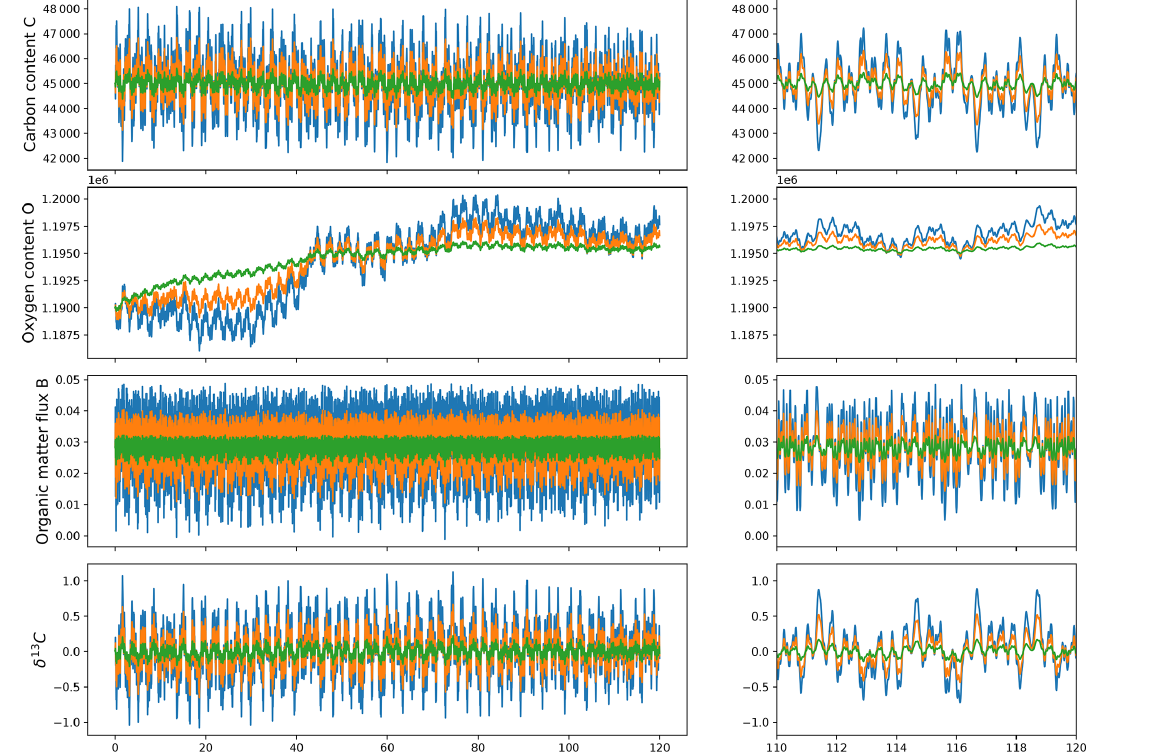
Figure 6. Modelled carbon content, C; oxygen content, O; organic matter flux, B ; and δ 13 C for different a f values ( a f = 0 . 01 in green, a f = 0 . 03 in orange, and a f = 0 . 05 in blue) when B 0 is a constant. The right panel is a zoom on the last 10Myr of the simulation.